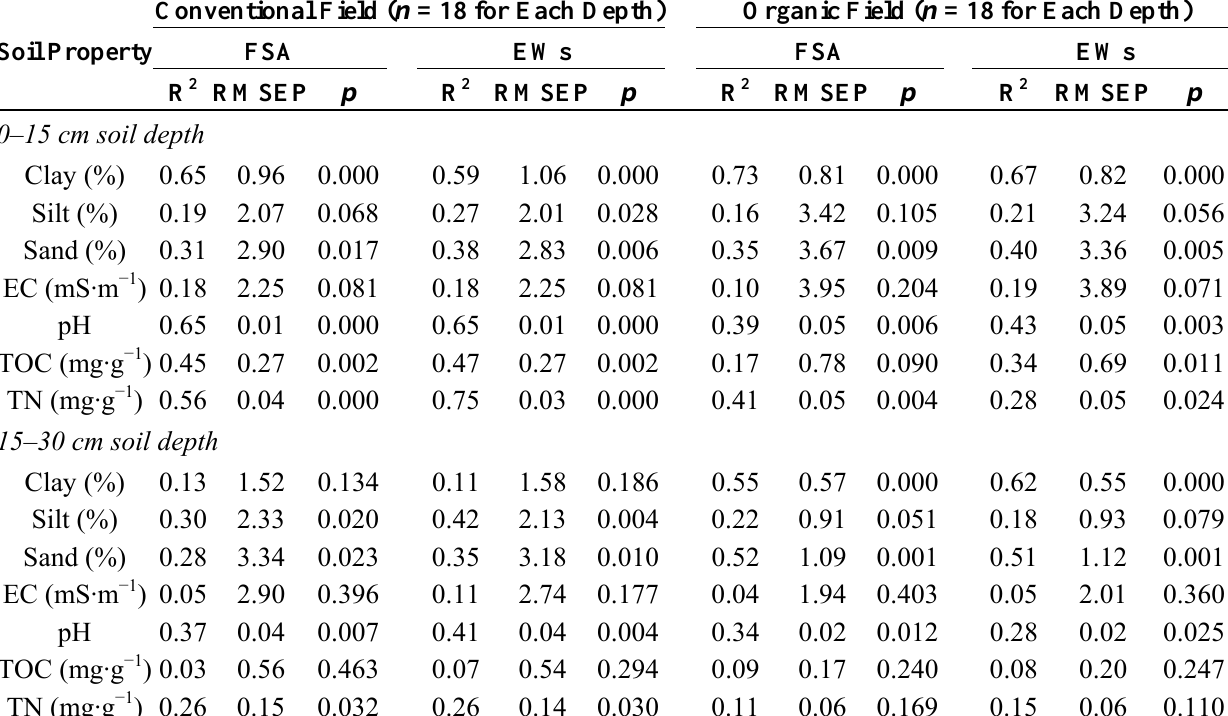
Table 6. Statistics of validation/predictions in individual fields using the FSA and the EWs methods. Soil